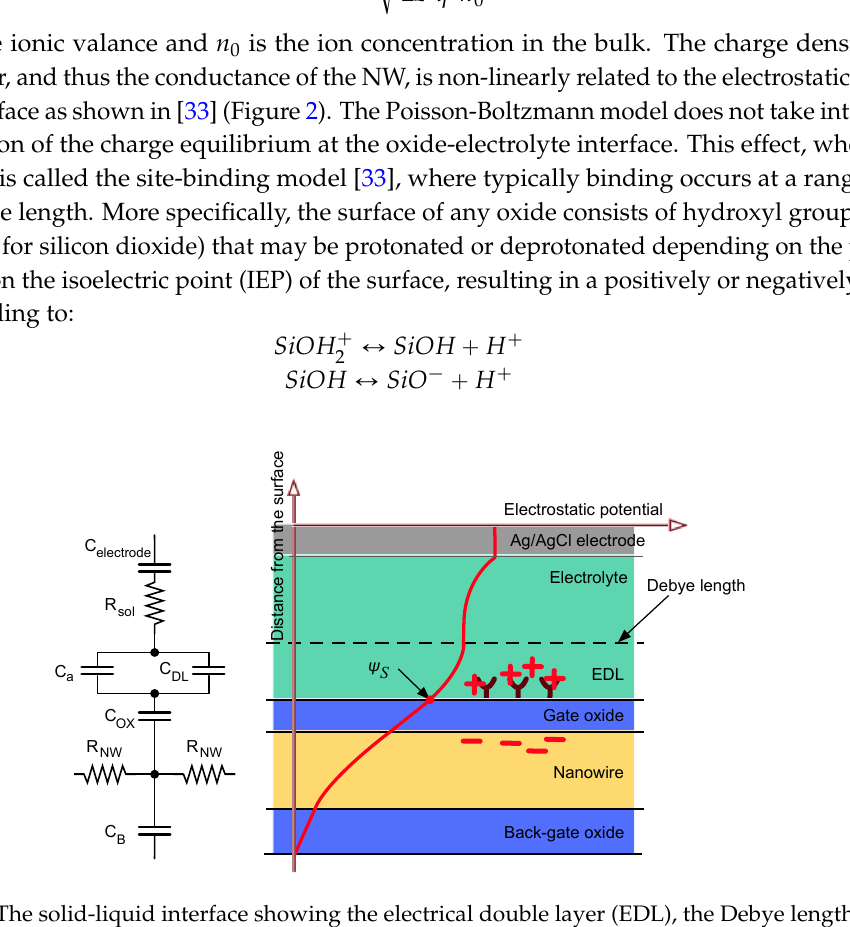
Figure 2. The solid-liquid interface showing the electrical double layer (EDL), the Debye length and electrostatic potential over the entire structure (from electrolyte to nanowire). A simplified version of the equivalent electrical model given by [34,35] is shown on the left, for the case of a small surface potential. C DL , C A , C OX , C B are the double layer, surface chemistry, oxide, and bulk capacitances, respectively. R SOL is the solution resistance and R NW is the NW resistance.